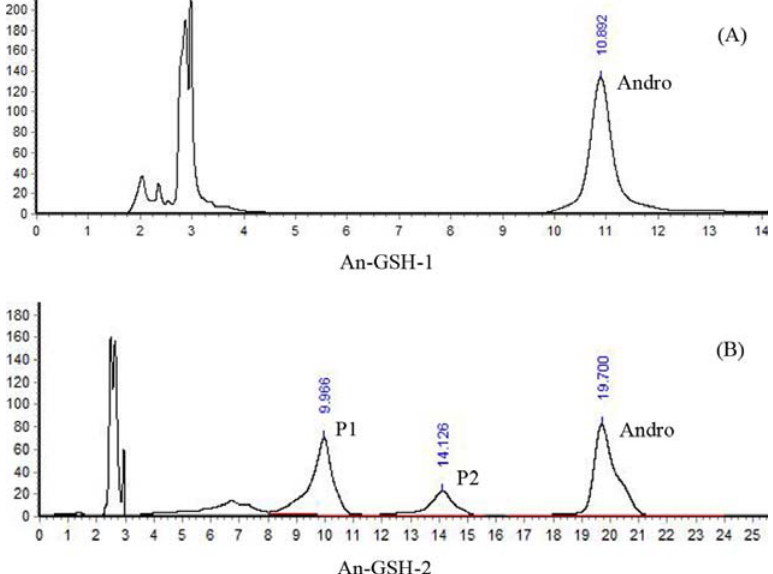
Figure 3. HPLC chromatograms of the reaction mixture of Andro and GSH. An-GSH-1 was analyzed by the mobile phase (1) methanol and water (52:48, v/v). An-GSH-2 was analyzed by the mobile phase (2) methanol and 0.1% v/v TFA solution (40:60, v/v).